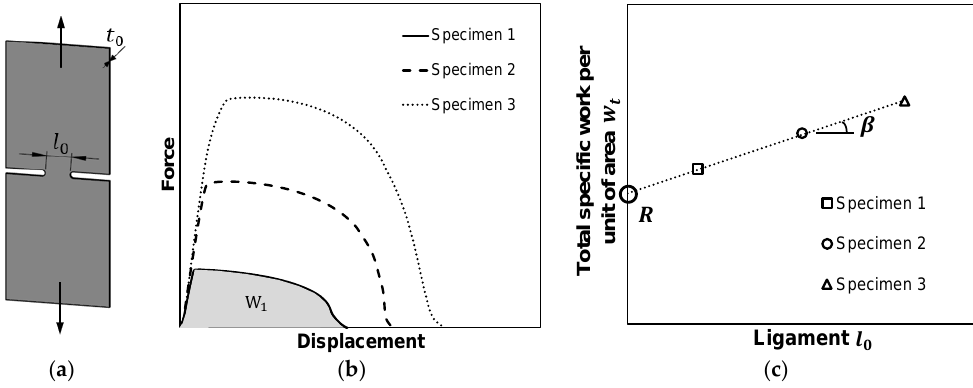
Figure 4. Schematic representation of the method utilised to determine fracture toughness 𝑅 . ( a ) Double edge notched tension test (DNTT) specimen. ( b ) Typical force-displacement evolution for DNTT specimens with different ligaments sizes 𝑙 0 . ( c ) Total specific work per unit of area 𝑤 𝑇 and extrapolation to obtain fracture toughness 𝑅 .